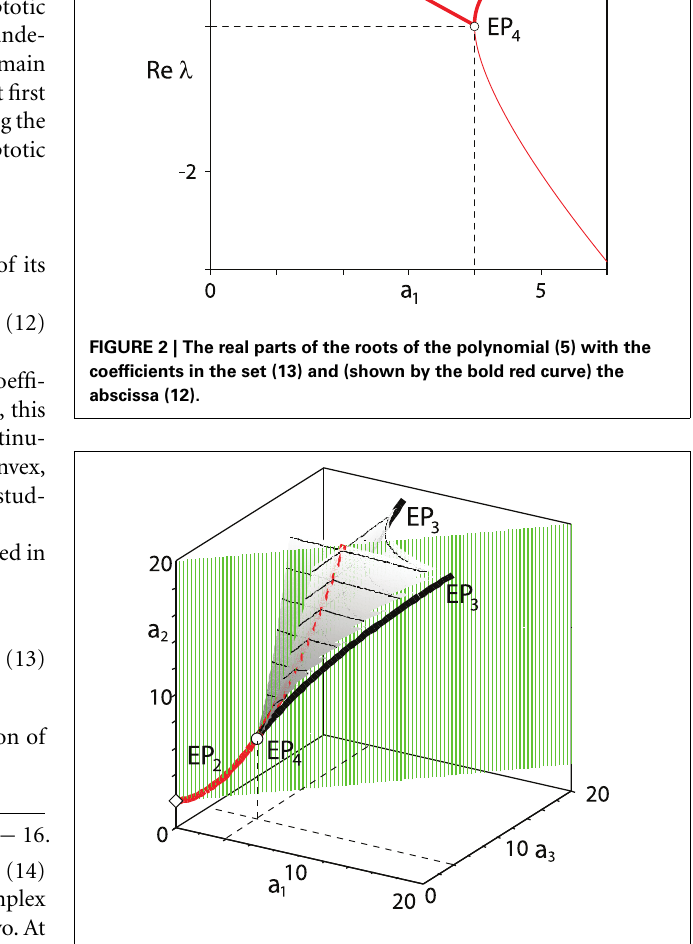
FIGURE 3 | The discriminant surface (gray) and the tangent cone (green) to the domain of asymptotic stability. Inside the tangent cone (10) the red curve marks the EP-set (13). The part of the EP-set above the Swallowtail singularity at the point ( 4 , 4 , 6 ) forms a line of self-intersection of the discriminant surface. The bold black curves are cuspidal edges of the discriminant surface corresponding to triple negative real